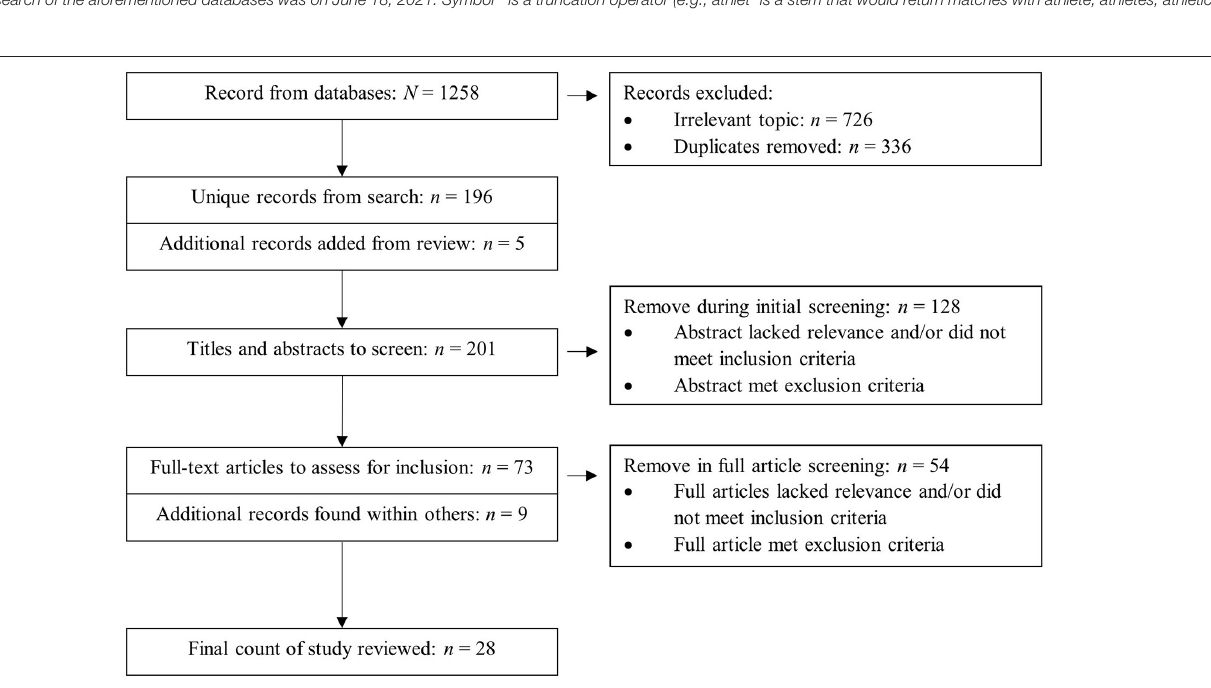
FIGURE 1 | PRISMA flowchart of search strategy and